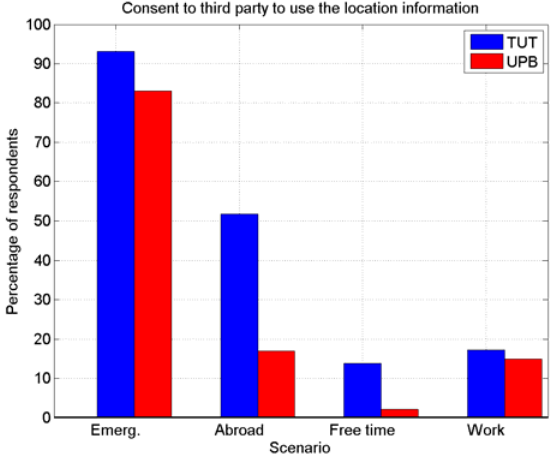
Figure 13. Consent to third party to use location information, according to user